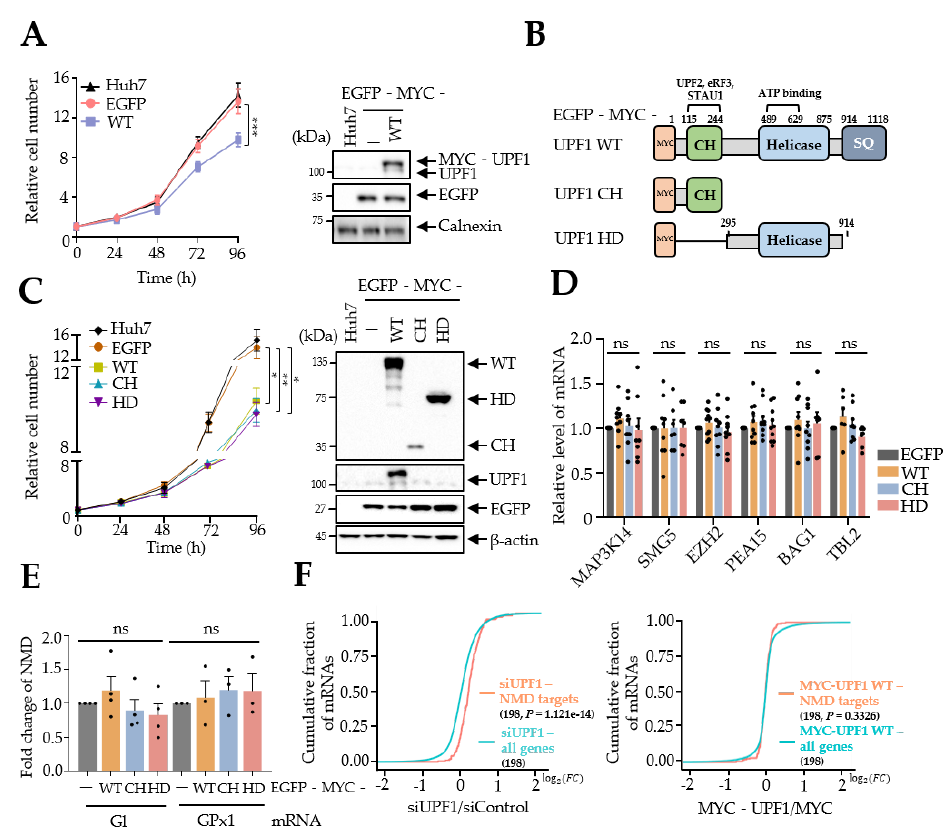
Figure 1. UPF1 deletion variants repressed Huh7 cell growth. ( A ) Huh7 cells that were infected with retrovirus expressing EGFP-MYC-UPF1 or EGFP as the negative control. Cell growth was measured by counting the cells over a period of 96 h. WB analysis was performed to evaluate the indicated proteins. ( B ) Schematic representation of UPF1 deletion variants. CH: cysteine/histidine rich region, HD: helicase domain, SQ: serine/glutamine region, MYC: myc tag. ( C ) Same as ( A ) except that Huh7 cells were infected with retrovirus expressing the indicated UPF1 deletion variants. Cell growth assays and WB analysis were performed. ( D , E ) NMD efficiency of endogenous NMD targets ( D ) and NMD reporters ( E ) was measured in UPF1 variant-expressing Huh7 cells by RT-qPCR. mRNA levels were normalized to those of GAPDH mRNA in ( D ) and MUP mRNA in ( E ). ( F ) Total RNA-seq was performed using UPF1-depleted or UPF1-overexpressing Huh7 cells. Cumulative log2 fold changes in expression in UPF1-depleted and UPF1-overexpressing cells compared with vehicle-transfected cells are shown as CDF plots using endogenous NMD targets. Indicated P values were estimated using the K-S test. The numbers in parentheses refer to endogenous NMD targets. * p ≤ 0.05; ** p ≤ 0.01; *** p ≤ 0.001; ns, not significant.